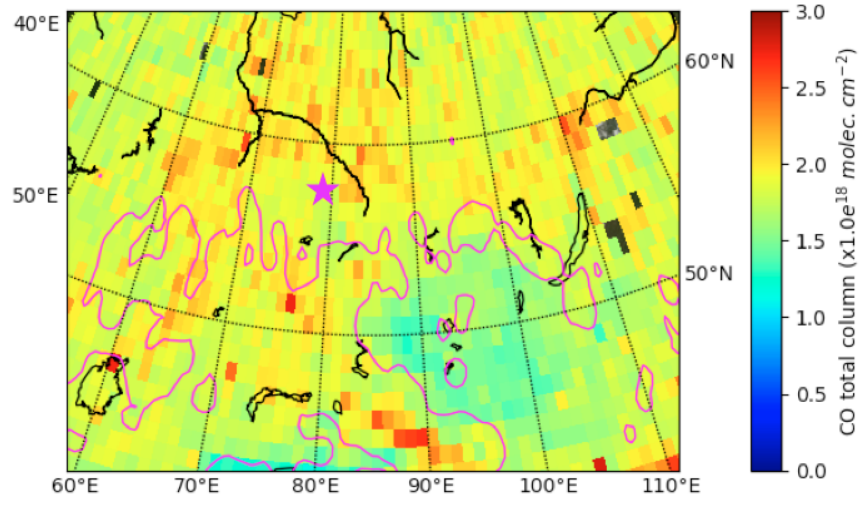
Figure 16. As Figure 5a for the time period 15–18 June